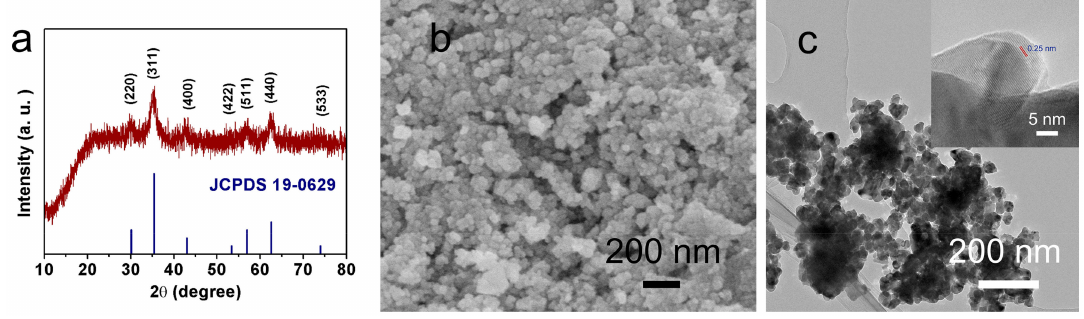
Figure 1. ( a ) XRD pattern; ( b ) Typical FESEM image; ( c ) TEM image of as-synthesized Fe 3 O 4